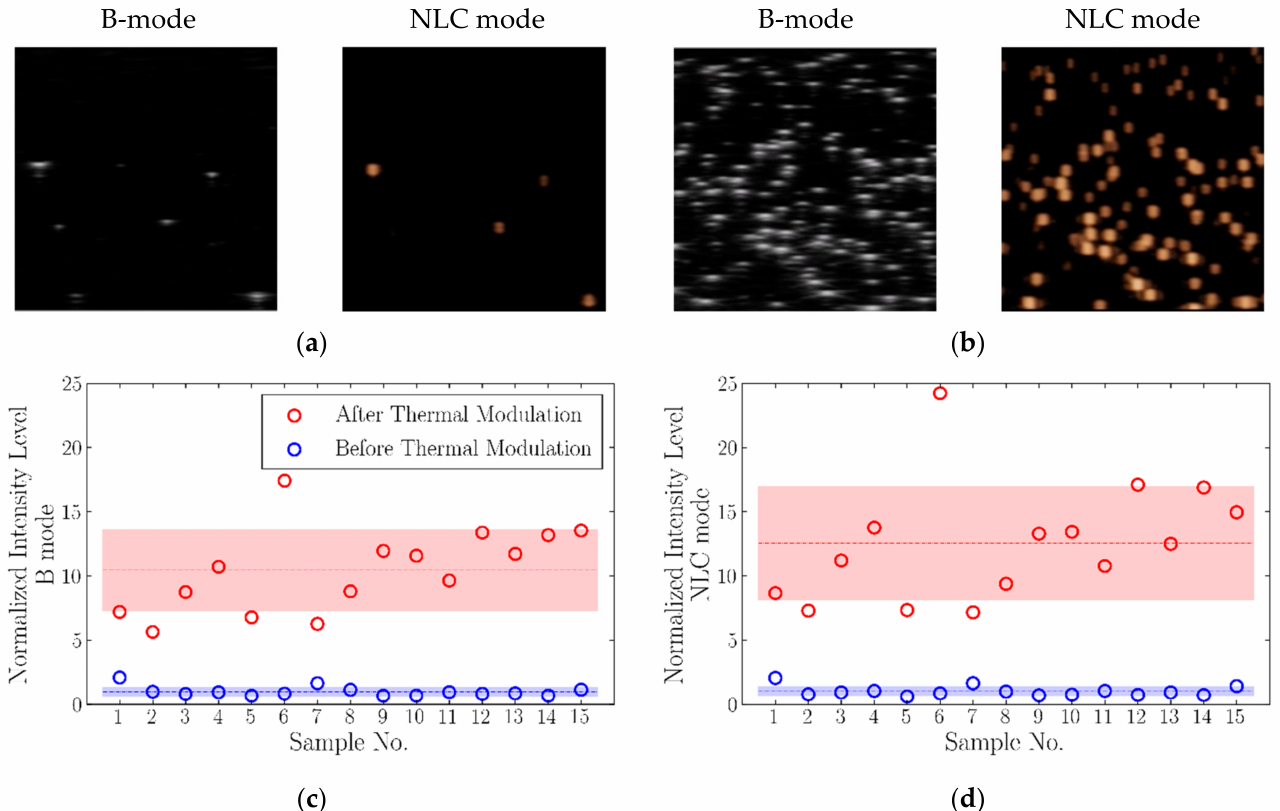
Figure 2. Analysis of nanodroplet echogenicity before and after thermal modulation. Representative ultrasound images of nanodroplets on the B-mode and the NLC mode ( a ) before and ( b ) after thermal modulation. ( c ) Nanodroplet signal intensity on the B-mode before and after thermal modulation. The data were normalized by the grand mean of signal intensity before the thermal cycle. ( d ) Nanodroplet signal intensity on the NLC mode before and after thermal modulation, normalized by the grand mean of signal intensity before